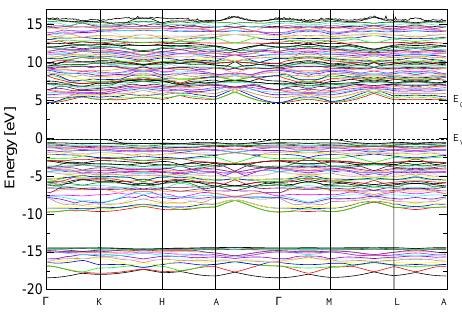
Fig. 2. Calculated band for cristalline α phase Si 3 N 4